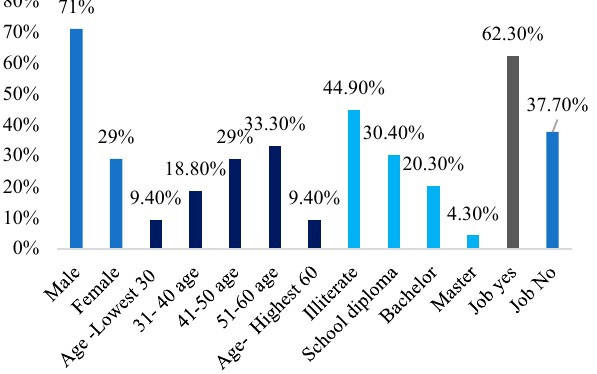
Figure 4. Characteristics of sex, age, education, and employment of urban households (in percent).